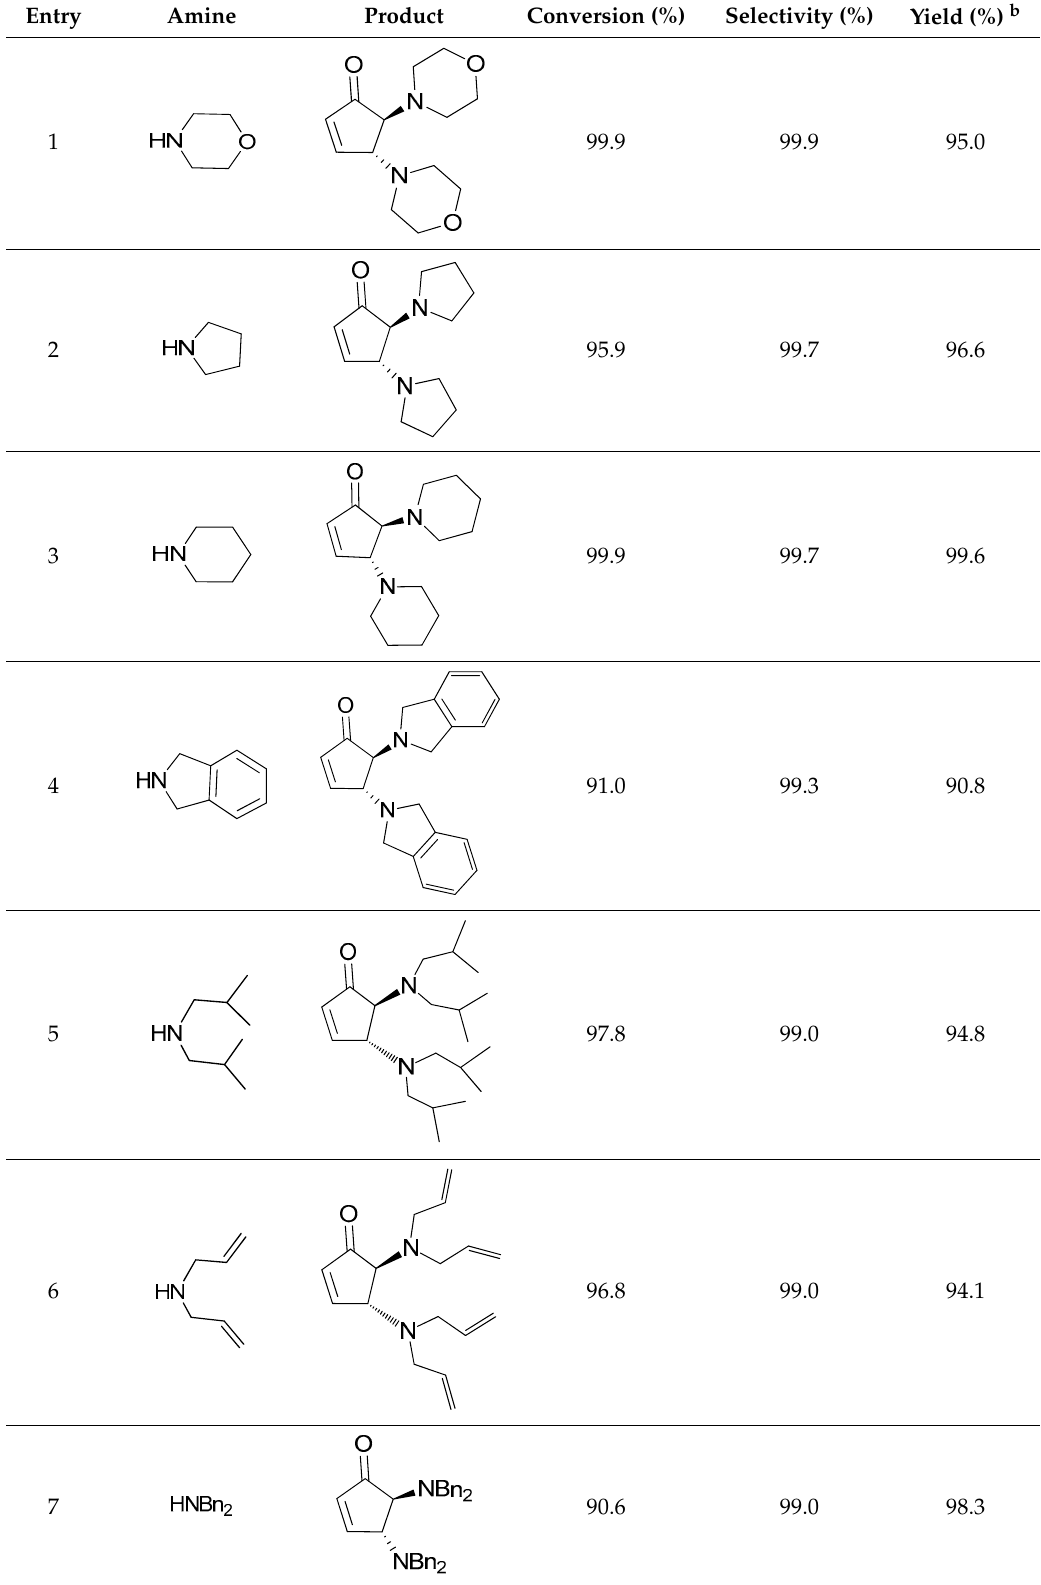
Table 2. Synthesis of bifunctionalized cyclopentenones. a